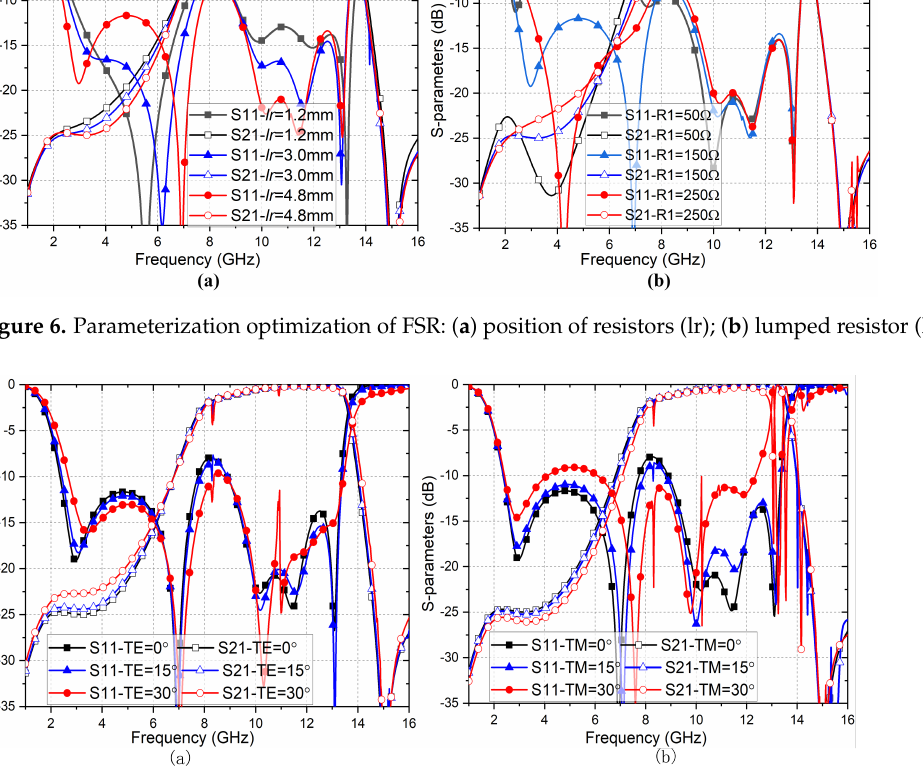
Figure 7. Reflection/transmission coefficients of proposed FSR for oblique incidence under ( a ) TE polarization and ( b ) TM polarization.